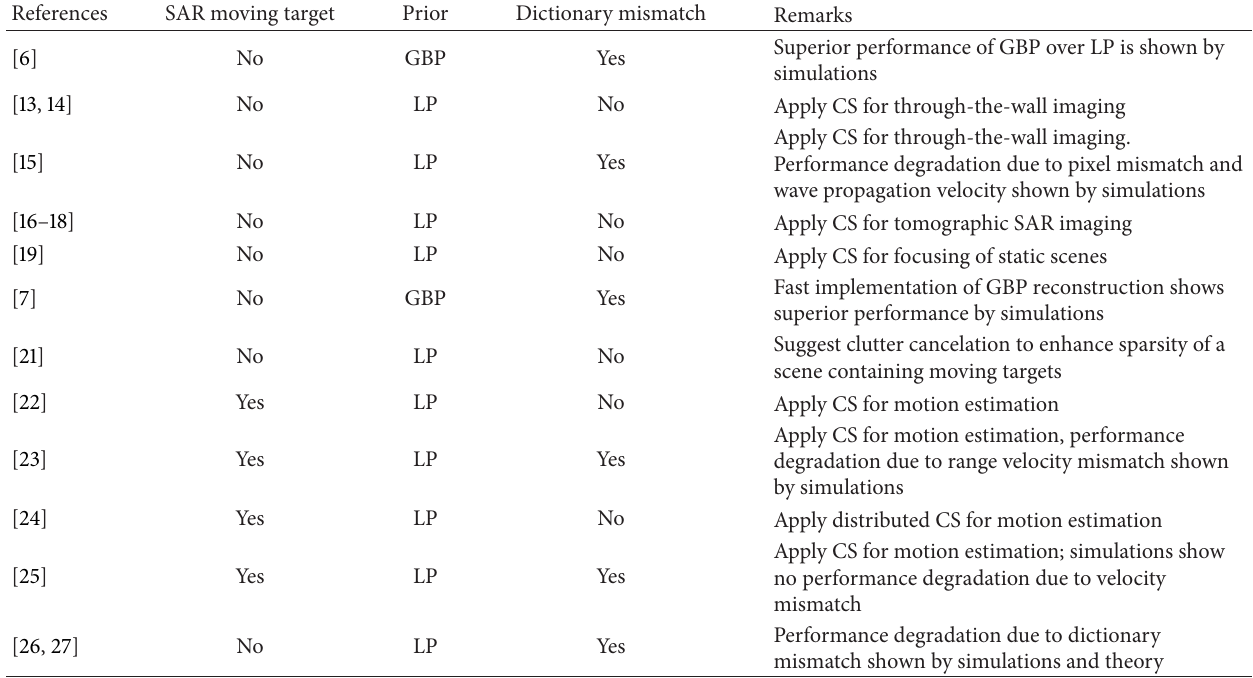
Table 1: Comparison of existing